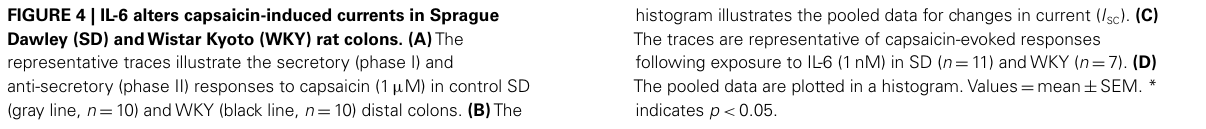
histogram illustrates the pooled data for changes in current ( I SC ). (C) The traces are representative of capsaicin-evoked responses following exposure to IL-6 (1nM) in SD ( n = 11) andWKY ( n = 7). (D) The pooled data are plotted in a histogram.Values = mean ± SEM. * indicates p <